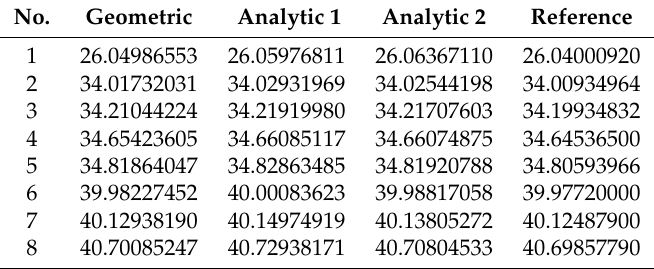
Table 9. The LD results of diferent positions. (The unit is